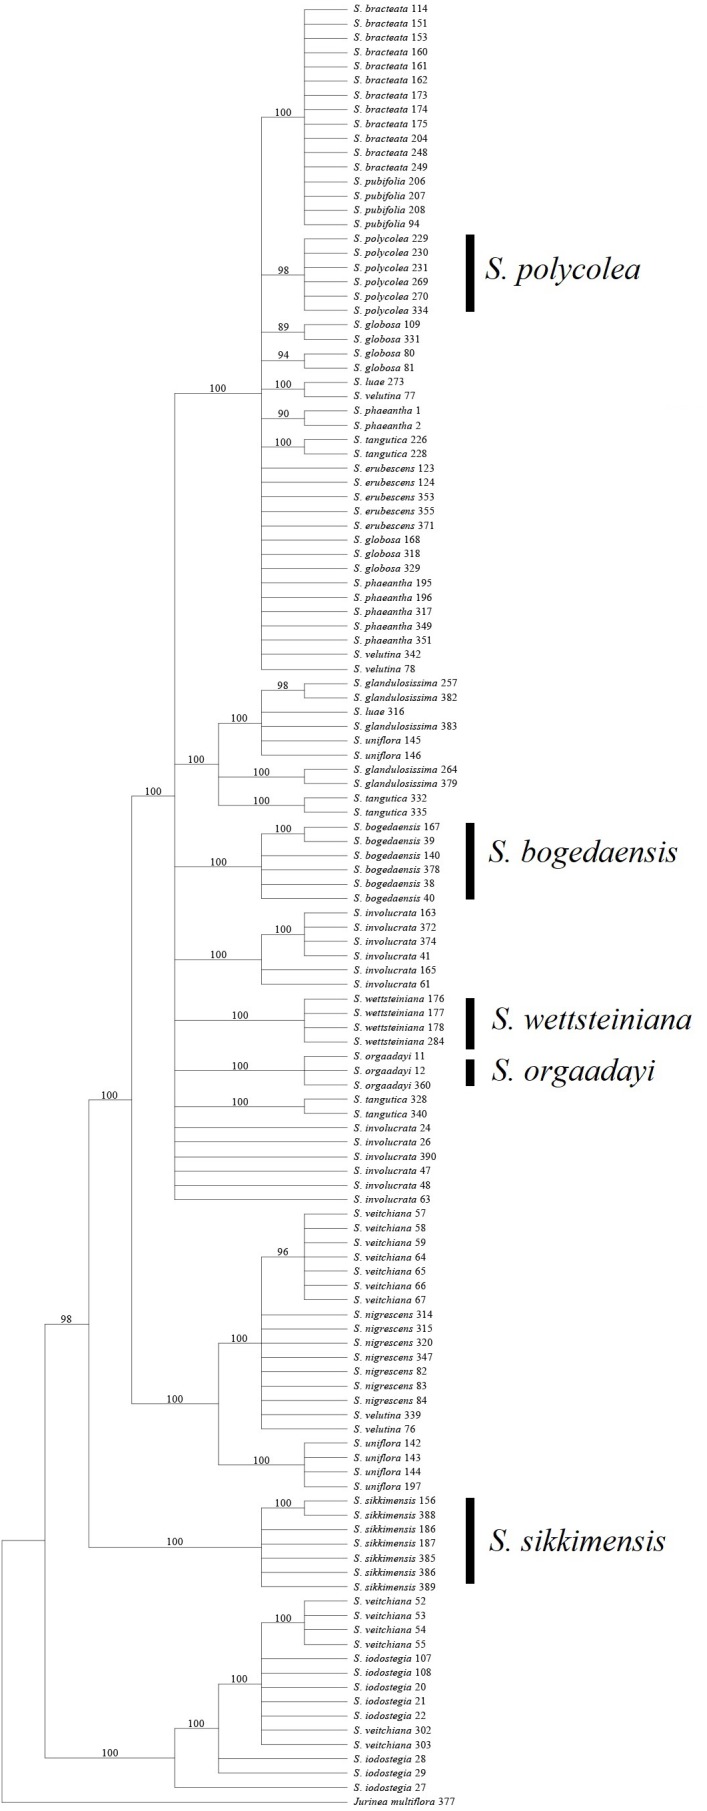
Phylogenetic tree based on Bayesian analysis of trnK +matK +psbA +rbcL.